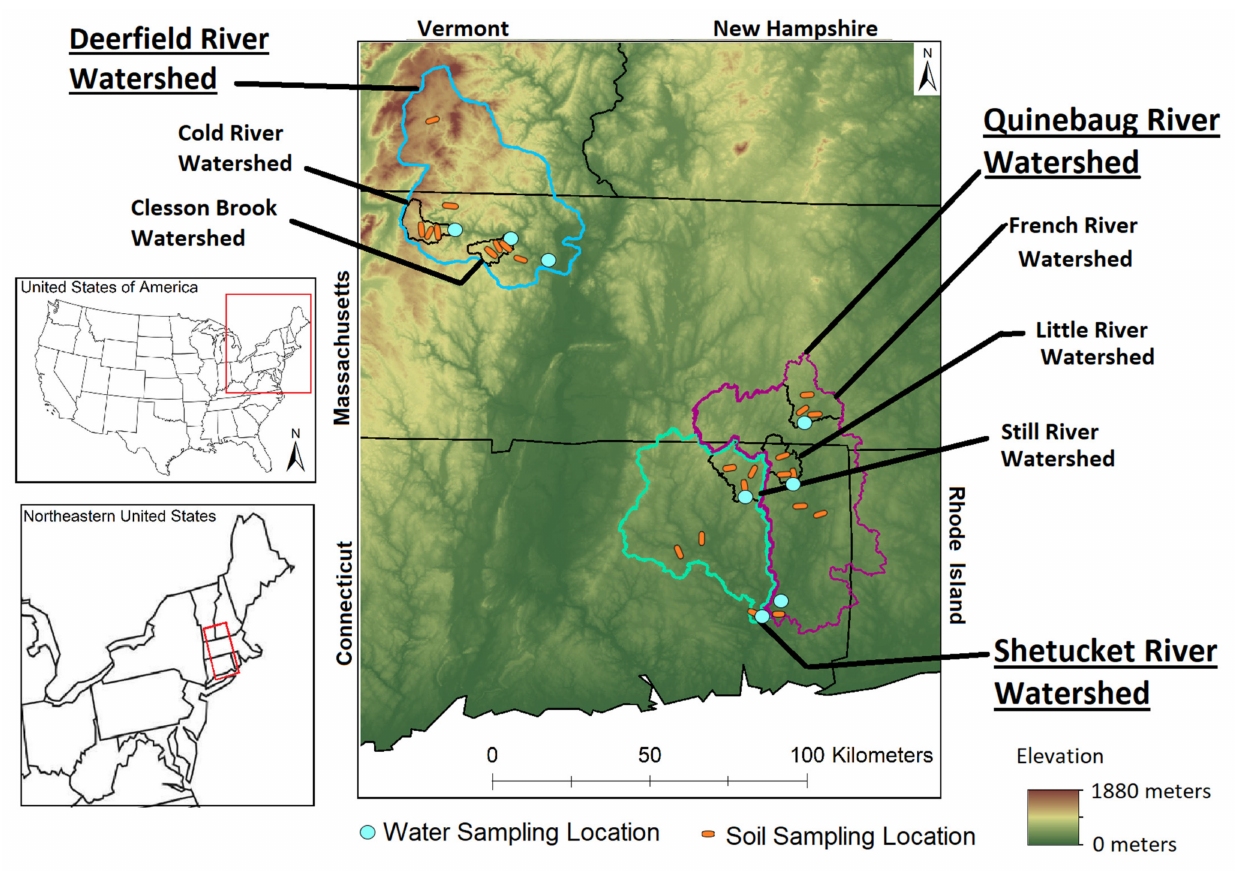
Figure 1. Digital elevation map and soil and water sampling locations in the Deerfield watersheds (and two of subwatersheds Cold River, Clesson Brook) of northwestern Massachusetts and the lowland, urbanized Quinebaug (and two subwatersheds Little and French River) and Shetucket watersheds (and its subwatershed Still River) of eastern